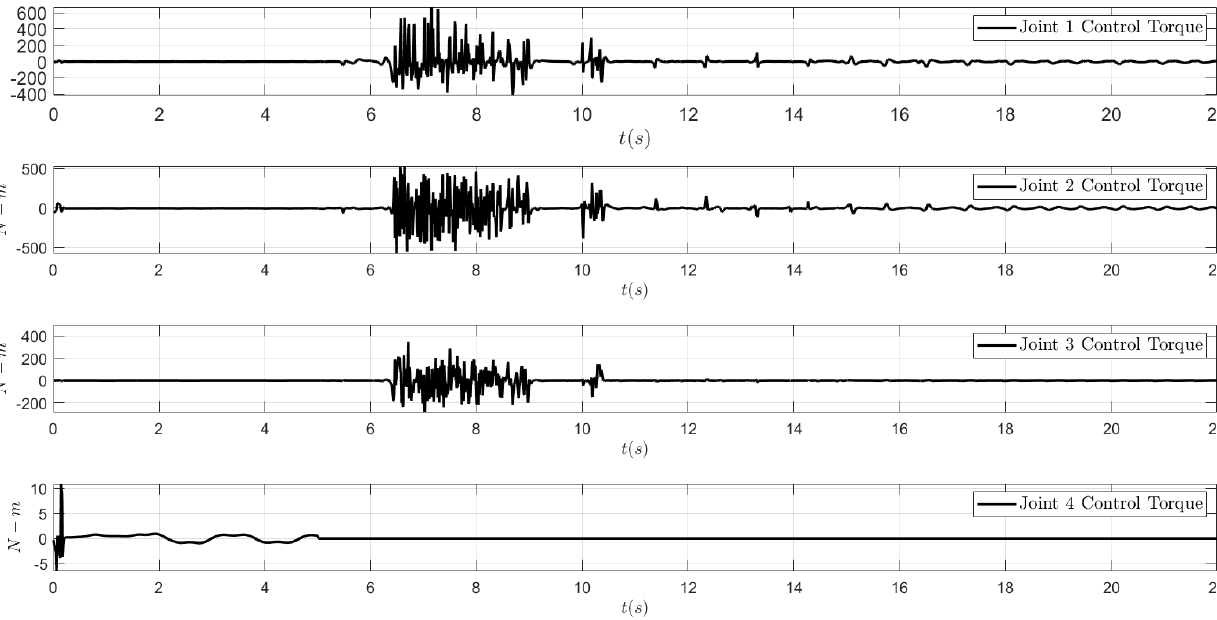
Figure 12. Control signal for the for the multi-step response shown in Fig. 11